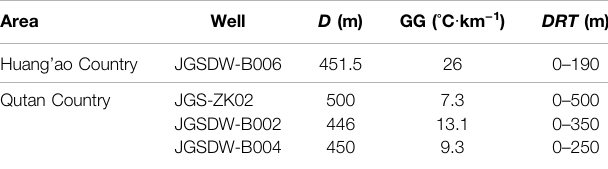
TABLE 2 | Geothermal gradients and their depth ranges of temperature